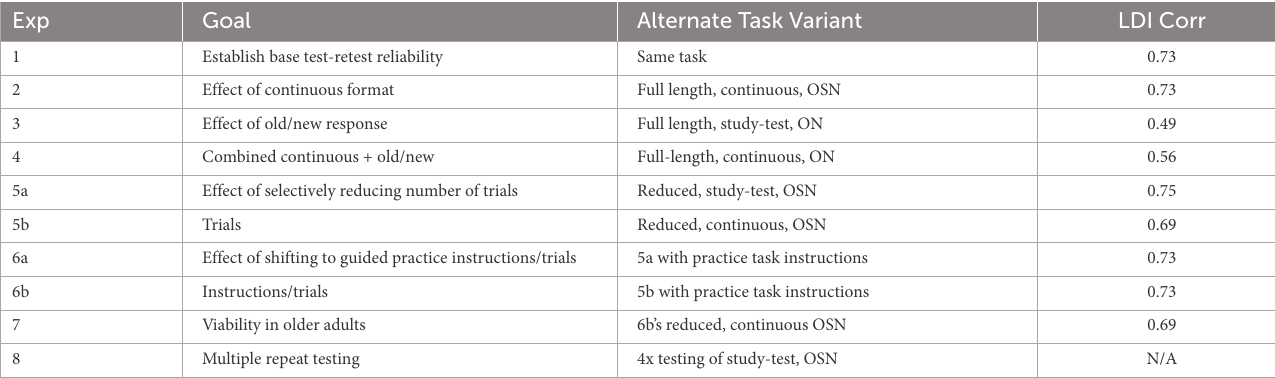
TABLE 1 For Experiment 1, subjects within each experiment performed two back-to-back sessions of the traditional, full-length MST that used the Study-Test format and Old, Similar, and New responses. Exp